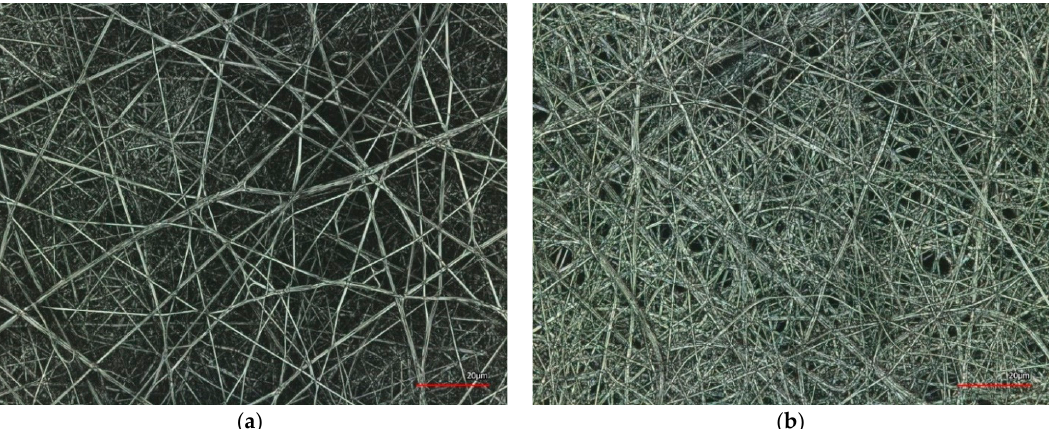
Figure 9. Confocal Laser Scanning Microscope (CLSM) images of PAN nanofiber mats on PLA object. PLA object is covered with nanofibers and is not visible: ( a ) sample—1, ( b ) sample—2. Scale bars indicate 20 μ m.